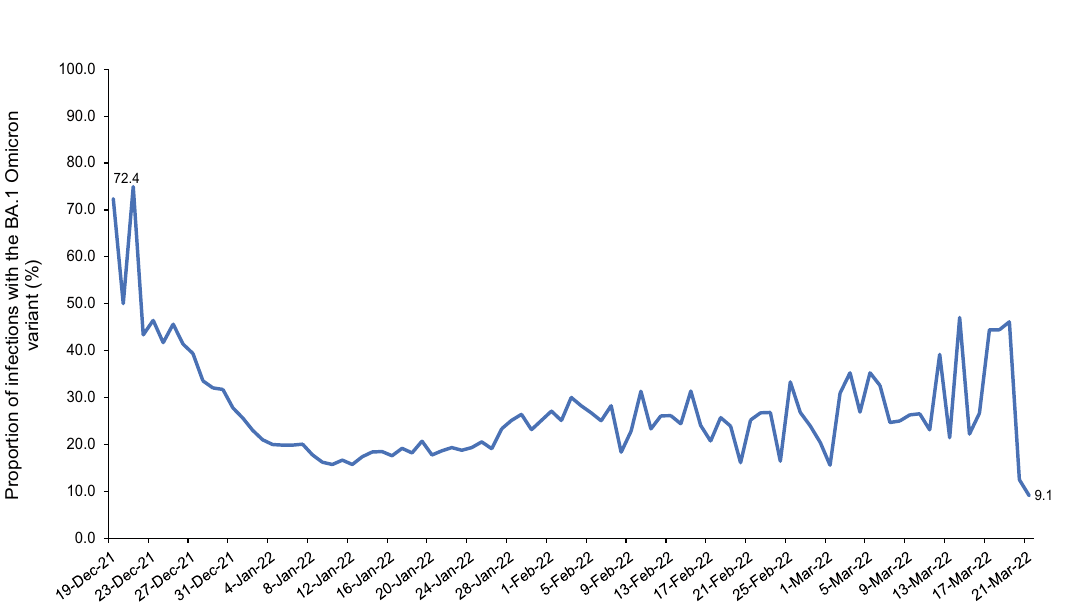
Fig. 1 | Distribution of SARS-CoV-2 BA.1 versus BA.2 Omicron infections. Proportion of BA.1 (versus BA.2) Omicron infections in PCR-positive tests assessed using TaqPath COVID-19 Combo Kit during the study